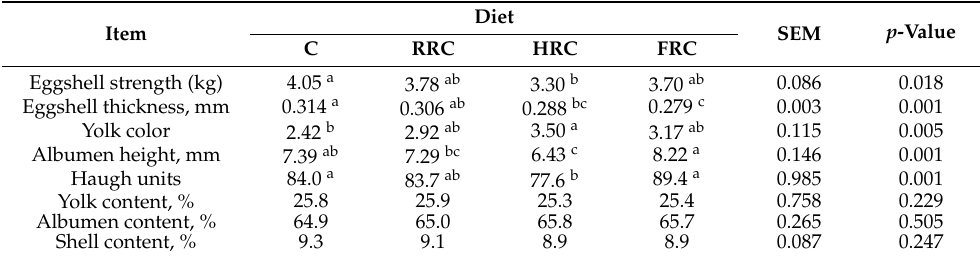
Table 4. Effect of raw (RRC), hydrobarothermally-treated (HRC) and fermented (FRC) rapeseed cake on the physicochemical properties of eggs 1 .